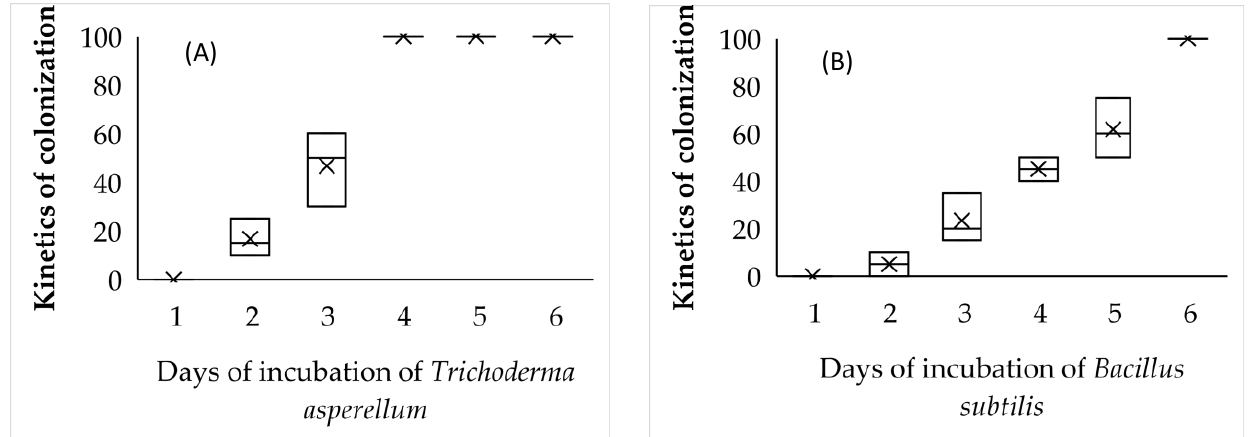
Figure 2. Kinetics of colonization. Kinetics of Trichoderma asperellum ( A ) and Bacillus subtilis ( B ), in M. spicata microplants.